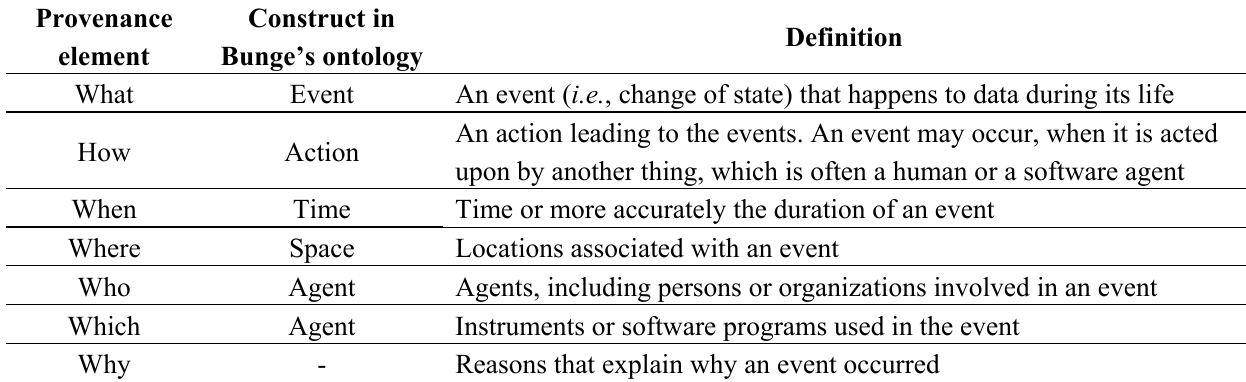
Table 4. Definition of the seven Ws (Source: